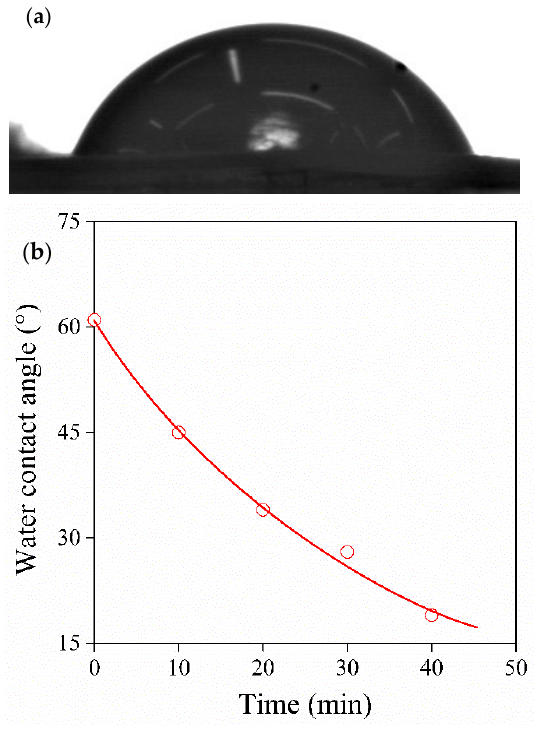
Figure 6. Wetting of a PLA disk prepared from electrospun fibers by water; ( a ) photo of a droplet used for the determination of contact angle, ( b ) decrease of contact angle with time due to the diffusion of liquid into the disk.